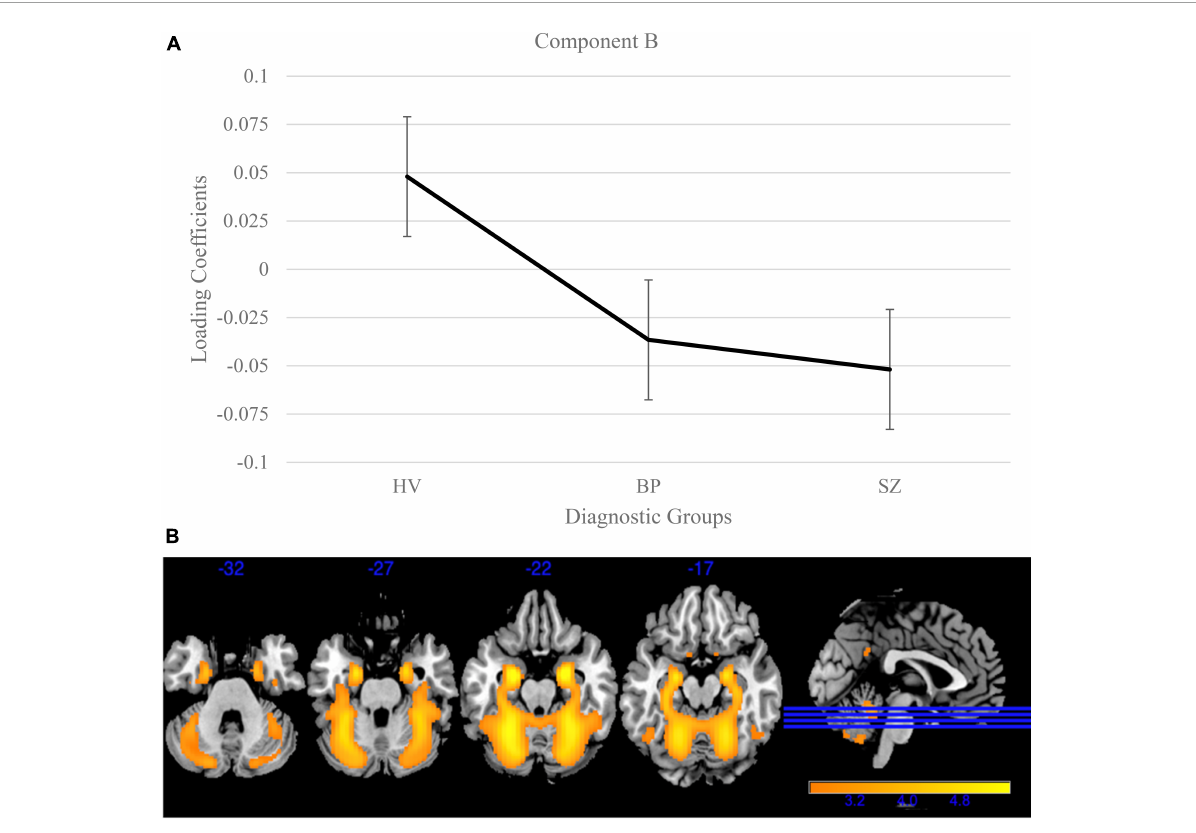
FIGURE2 Cerebellum and vermis gray matter group differences in independent component analysis (ICA) results for healthy volunteers, individuals with schizophrenia, and individuals with bipolar I disorder. (A) Group effects of diagnosis on loading coefficients for Component B. Schizophrenia (SZ) and bipolar disorder (BP) had significantly less gray matter compared to healthy volunteers but did not significantly differ from each other. (B) Component B showed less gray matter concentration in the cerebellum and vermis in individuals with SZ and individuals with BP compared to healthy volunteers. Images thresholded at